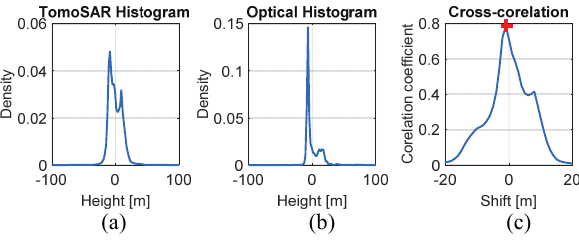
Figure 6. (a) The height histogram of TomoSAR point cloud, (b) the height histogram of LiDAR point cloud, and (c) the correlation of (a) and (b), where the red cross marks the peak position which is at -2